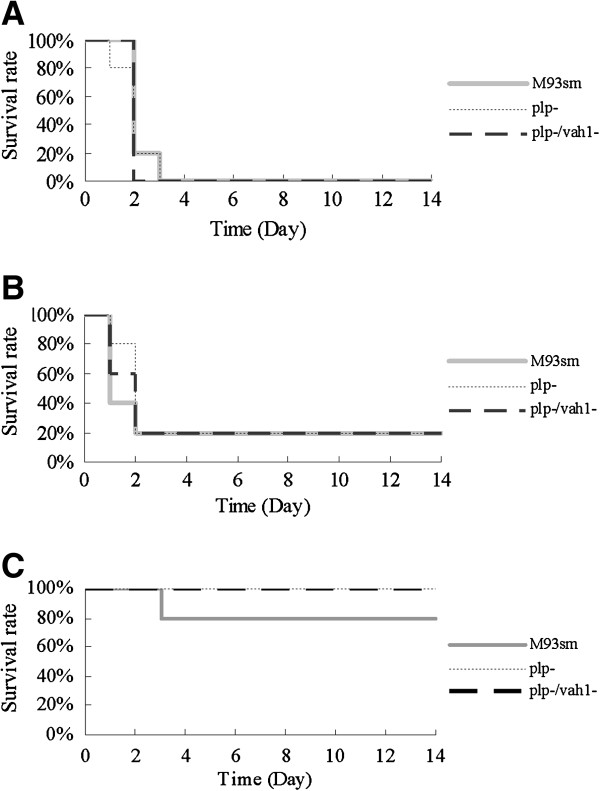
Survival rate of rainbow trout injected IP with wild type (M93Sm, solid grey line) and mutant (plp, grey dotted line; plp vah1, black dashed line) strains of V. anguillarum strains at doses of A) 3 × 106, B) 3 × 105 or C) 3 × 104 CFU/fish. No statistically significant difference was observed between the strains.